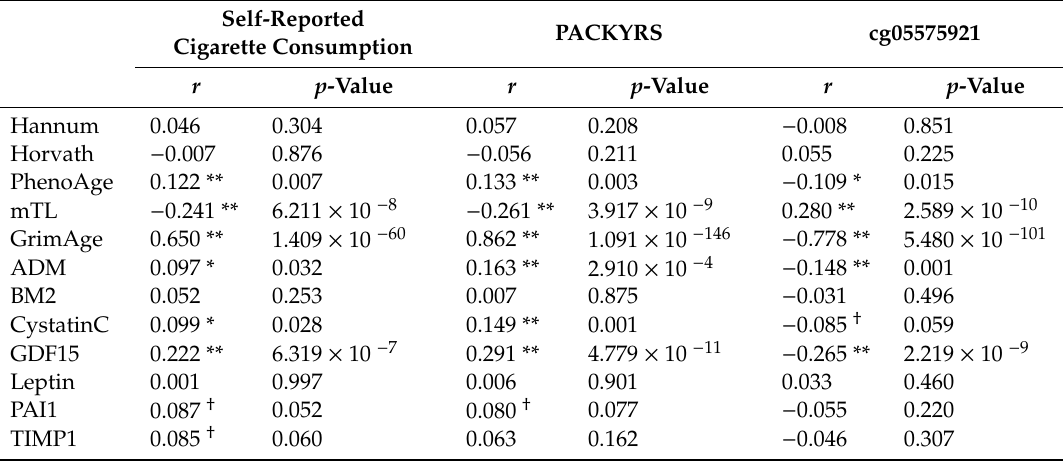
Table 1. Partial correlation between cigarette use and DNA methylation-based aging indices, controlling for BMI, gender, and cell-types (Monocytes, natural killer, CD8 + T, CD4 + T, and Bcells) (N = 500)